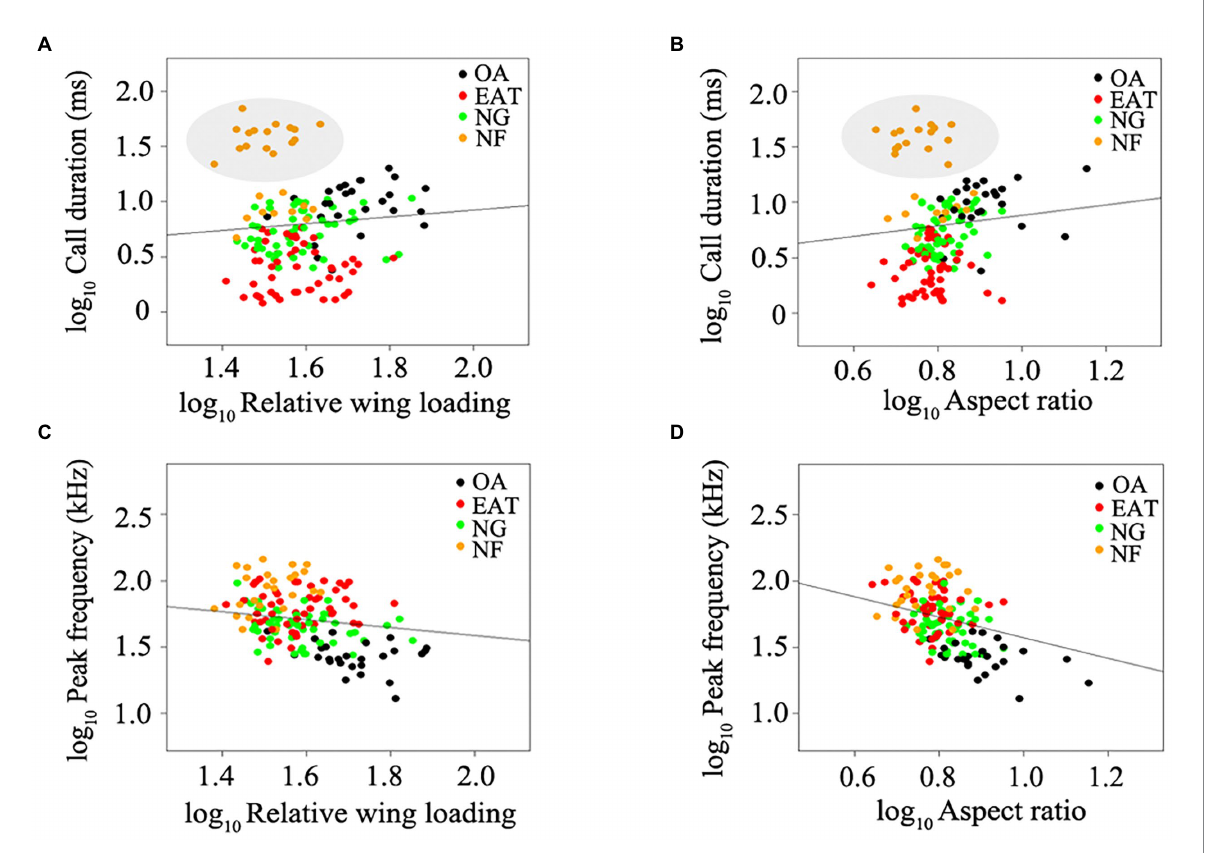
FIGURE 1 Relationship between wing morphology and echolocation call parameters among all bats studied. (A) Relative wing loading and call duration. (B) Aspect ratio and call duration. (C) Relative wing loading and peak frequency. (D) Aspect ratio and peak frequency. Black plots represent open- space aerial forager (OA). Red plots represent edge-space aerial and trawling forager (EAT). Green plots represent narrow-space gleaning forager (NG). Orange plots represent narrow-space flutter-detecting forager (NF). Data in ellipses represent rhinolophids and the mormoopid Pteronotus parnellii. Lines represent the best-fitting regression models after correcting for